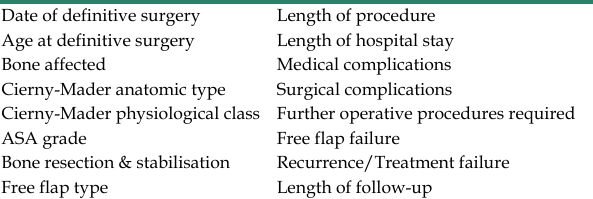
Table 1 : Data fields collected from electronic patient